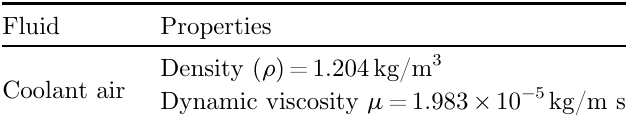
Table 2. Initial conditions of coolant applied for the numerical simulation.